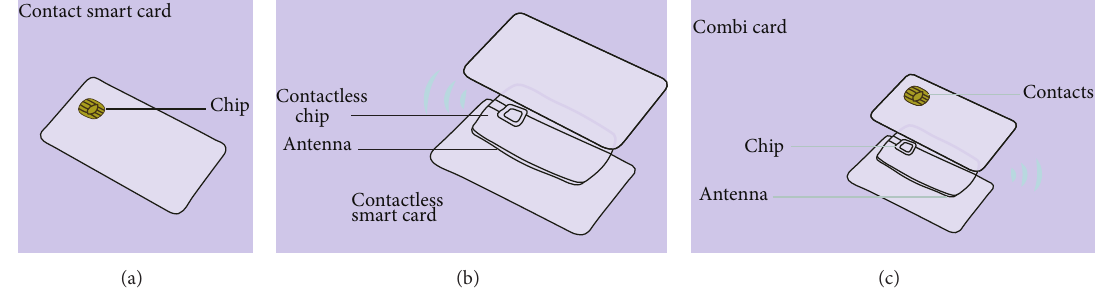
Figure 1: (a) Contact smart card, (b) contactless smart card, and (c) combi